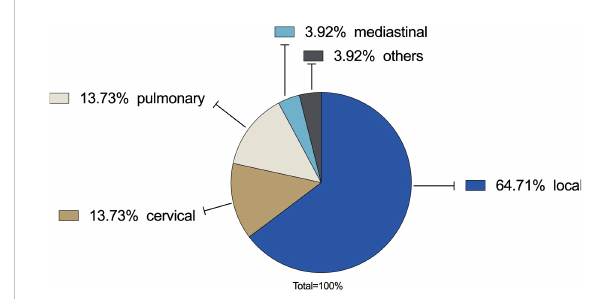
FIGURE 4 Recurrence rate: In 29.31% a relapse occurred. Local relapse was the most common type with 64.71% (N=33) followed by regional cervical lymph node metastases (13.73%, N=7) and distant pulmonary metastases (13.73%, N=7). Mediastinal metastases were found in 3.73% (N=2). Others were 3.73%